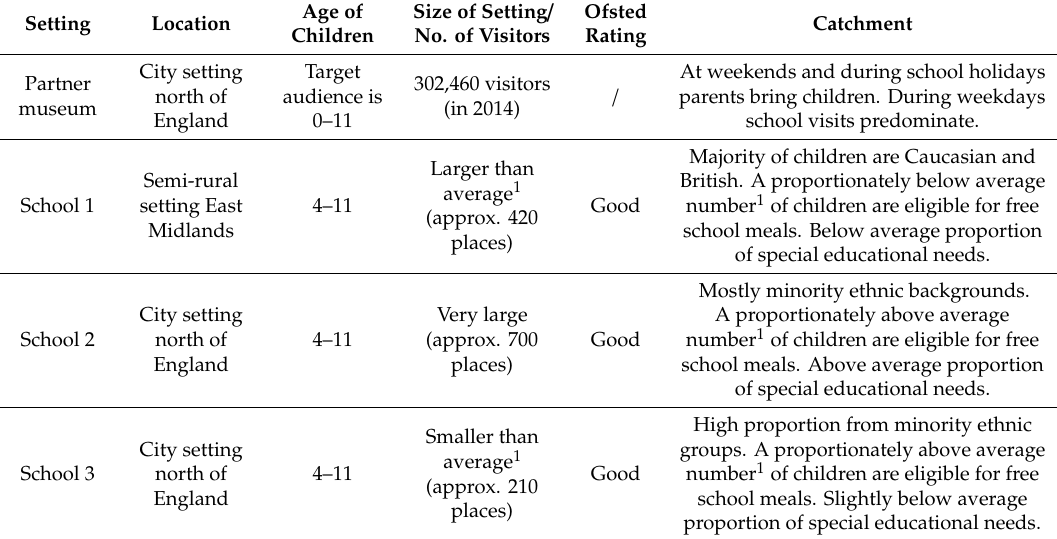
Table 2. Setting